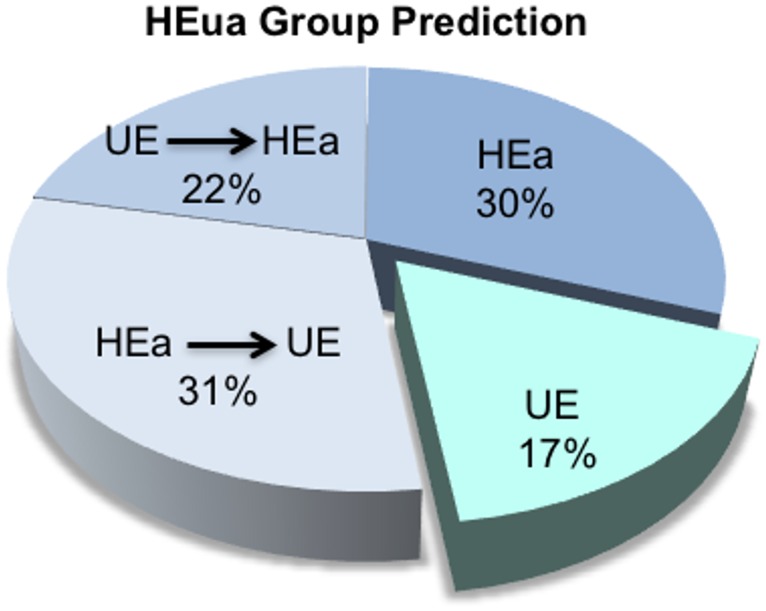
Classification of maternal samples from the HEua group.Pie chart shows classification of the HEua group as either like HEa or HEua groups. 17% of pregnant mothers assigned to the HEua group were classified as UE-like throughout pregnancy. 52% were either like the HEa (30%) throughout pregnancy or moved from being UE-like at mid pregnancy to HEa like (22%) by the end of pregnancy. However, 31% of HEua mothers were HEa-like at mid pregnancy, but more UE-like by the end of pregnancy.